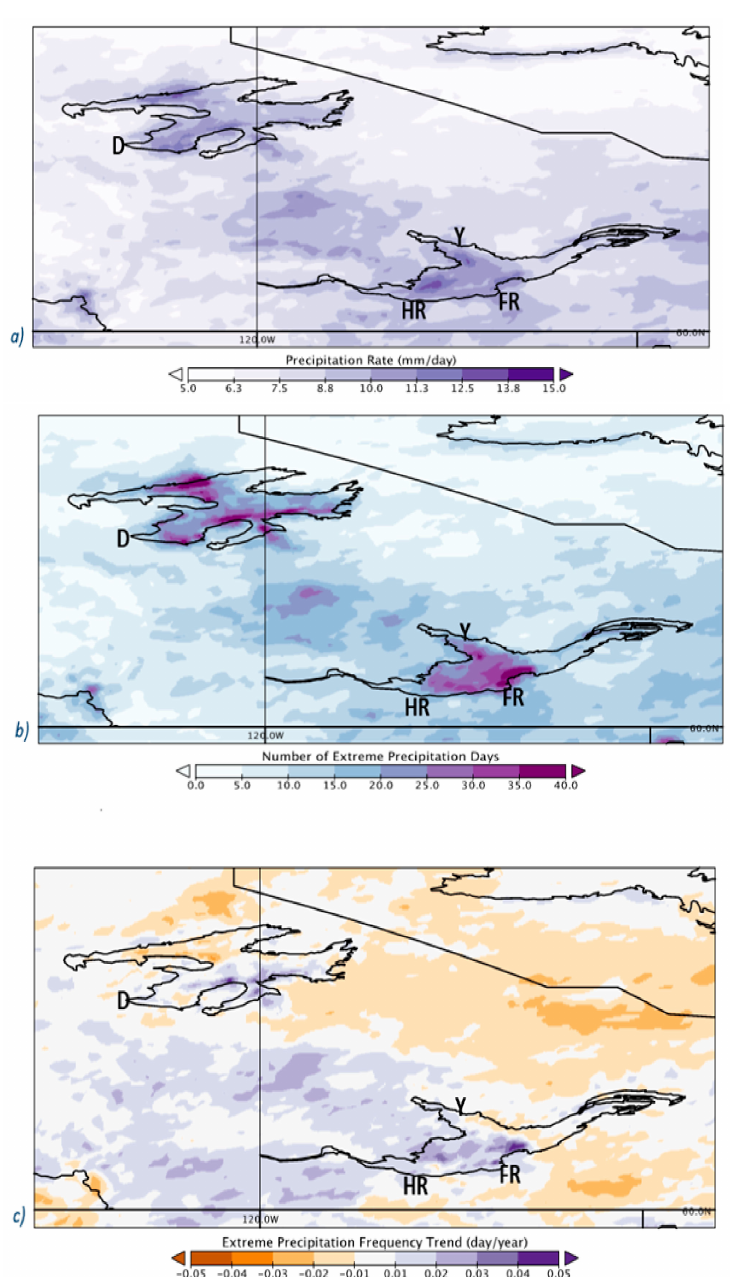
Figure 2. Precipitation exposure variable for the past (1980-2014) simulation driven by ERA_Interim: ( a ) 99th percentile of daily November precipitation intensity, ( b ) number of days exceeding 8 mm/day of precipitation for November over the 35-year period, ( c ) trend in frequency of extreme precipita- tion